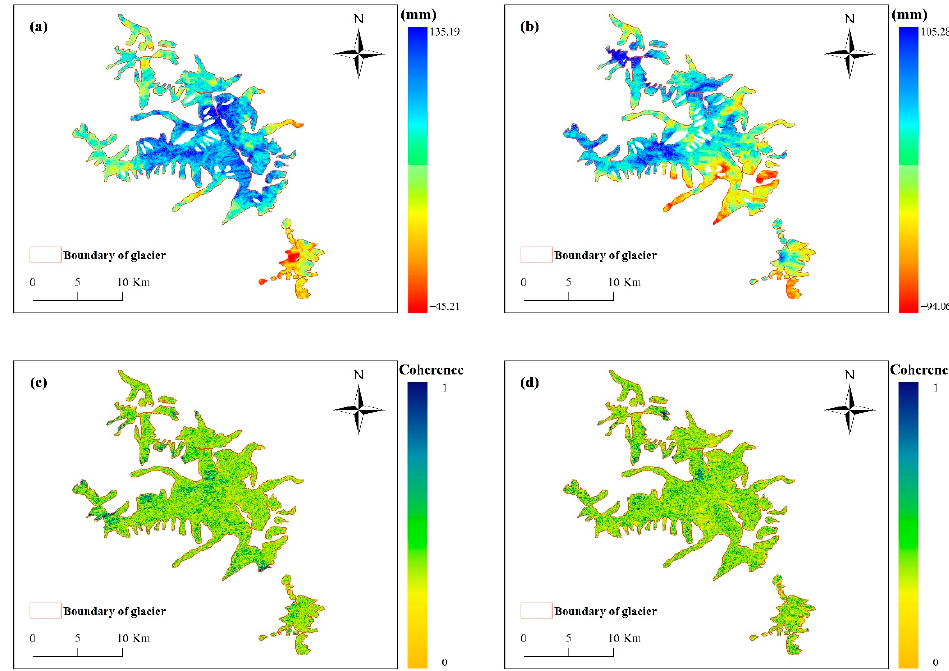
Figure 4. Deformation results in the direction of the DInSAR line-of-sight, ( a ) is the result of ascending orbit, ( b ) is the result of descending orbit, ( c ) is the coherence of ascending orbit, ( d ) is the coherence of descending orbit.